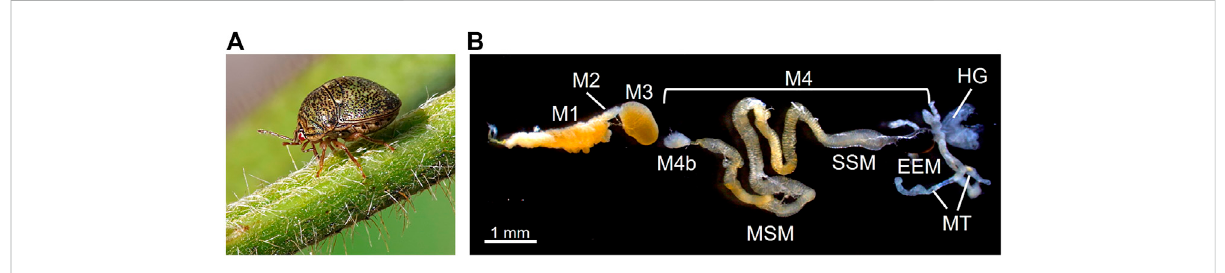
FIGURE 1 Extracellular gut symbiotic system of the stinkbug M. punctatissima . (A) An adult insect feeding on kudzu plant. (B) The alimentary tract dissected from an adult female. The fi rst three midgut sections (M1-M3) are involved in food digestion and absorption. The uncultivable bacterial symbiont Ishikawaella is housed in the fourth midgut section (M4), which is further divided into the M4 bulb (M4b), main symbiotic midgut (MSM), swollen symbiotic midgut (SSM), and enlarged end midgut (EEM). The posterior end of M4 is connected to the Malpighian tubeles (MT) and hindgut (HG). Males lack MSM and EEM for production of symbiont-containing capsules for vertical transmission (see Hosokawa et al., 2005; Koga et al.,